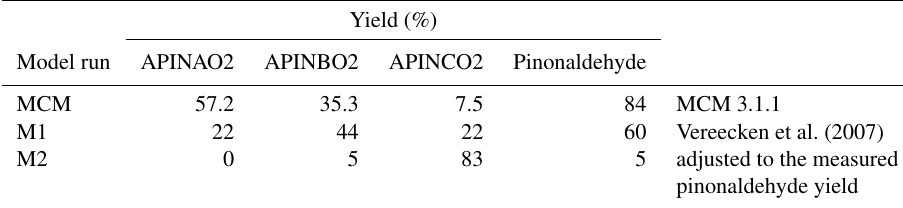
a Yield determined in the 2014 experiment. b Combined yield from experiments in 2012 and 2014. Table 3. RO 2 yields for the different model runs and the resulting pinonaldehyde yields for the chamber